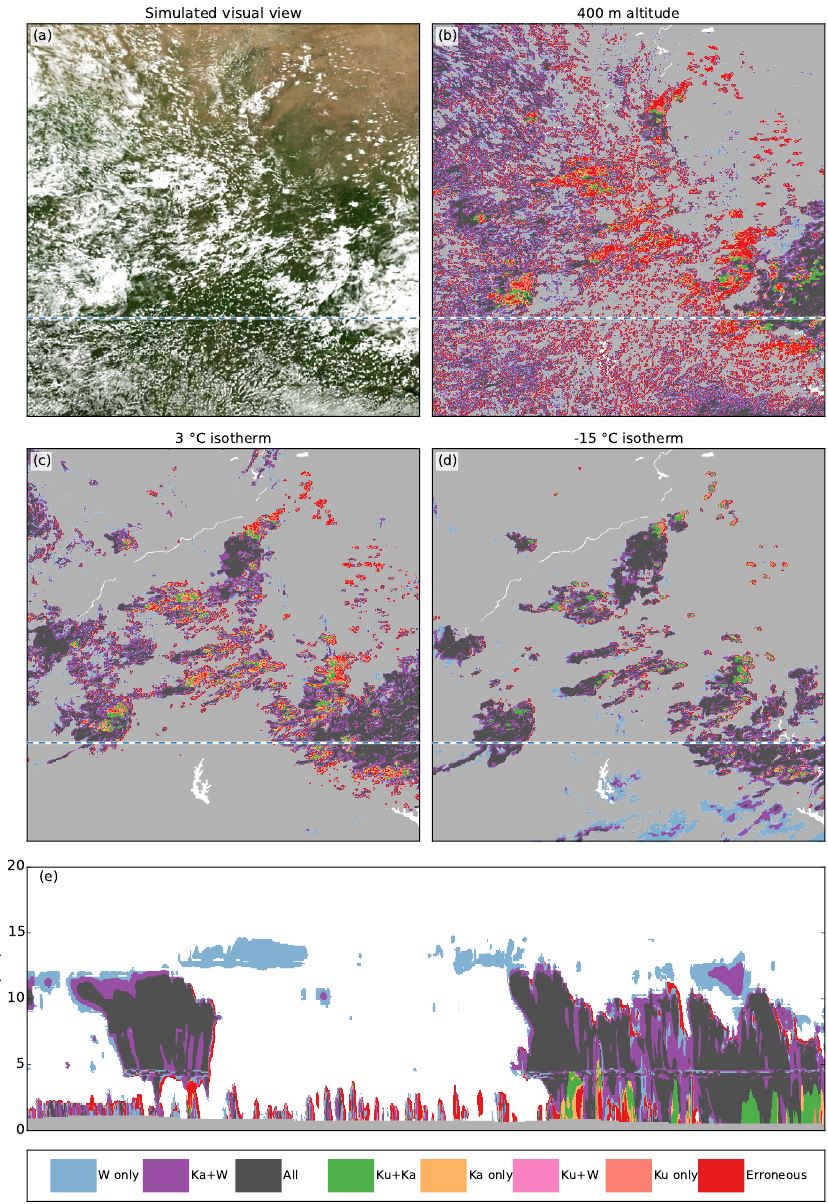
Figure 8. As in Fig. 6, but for tropical overland convection (Sect. 5.3; TLC in Fig.